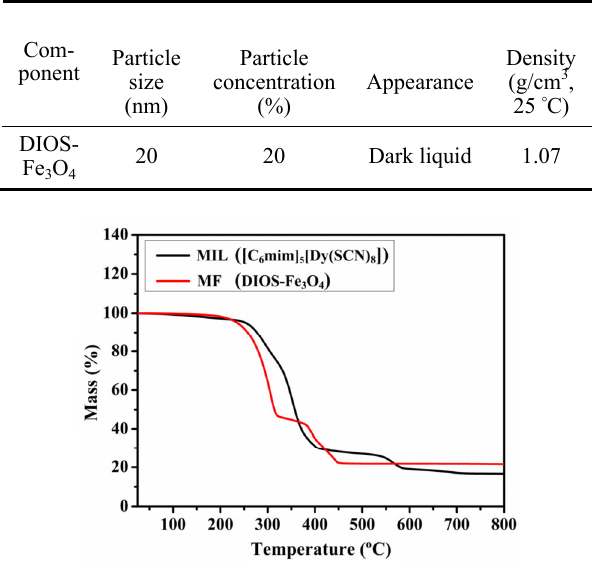
Fig. 1 Molecular structure of the MIL. Table 1 Details about the appearance, density, particle size, and concentration of the MF.